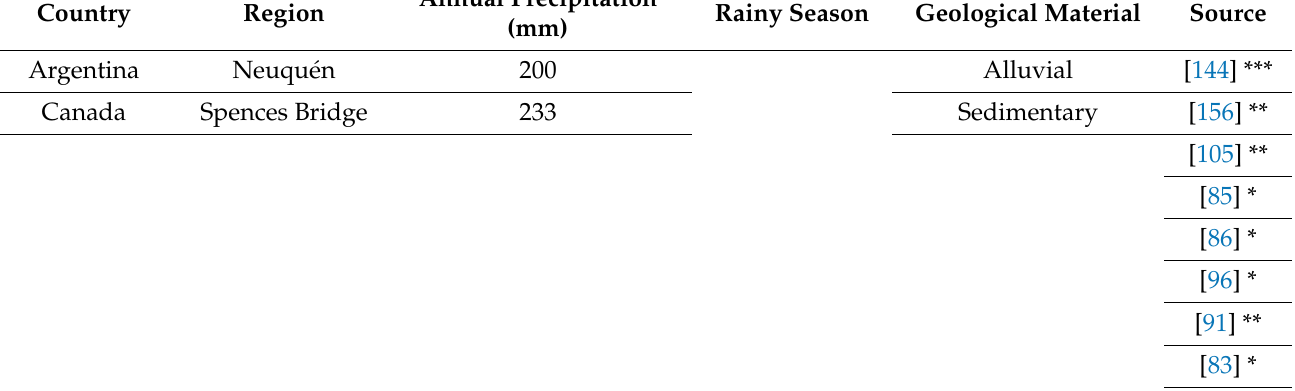
Table 1. Documented cases of irrigation-induced landslides within the Chinese (*), English (**), and Spanish (***) literature.